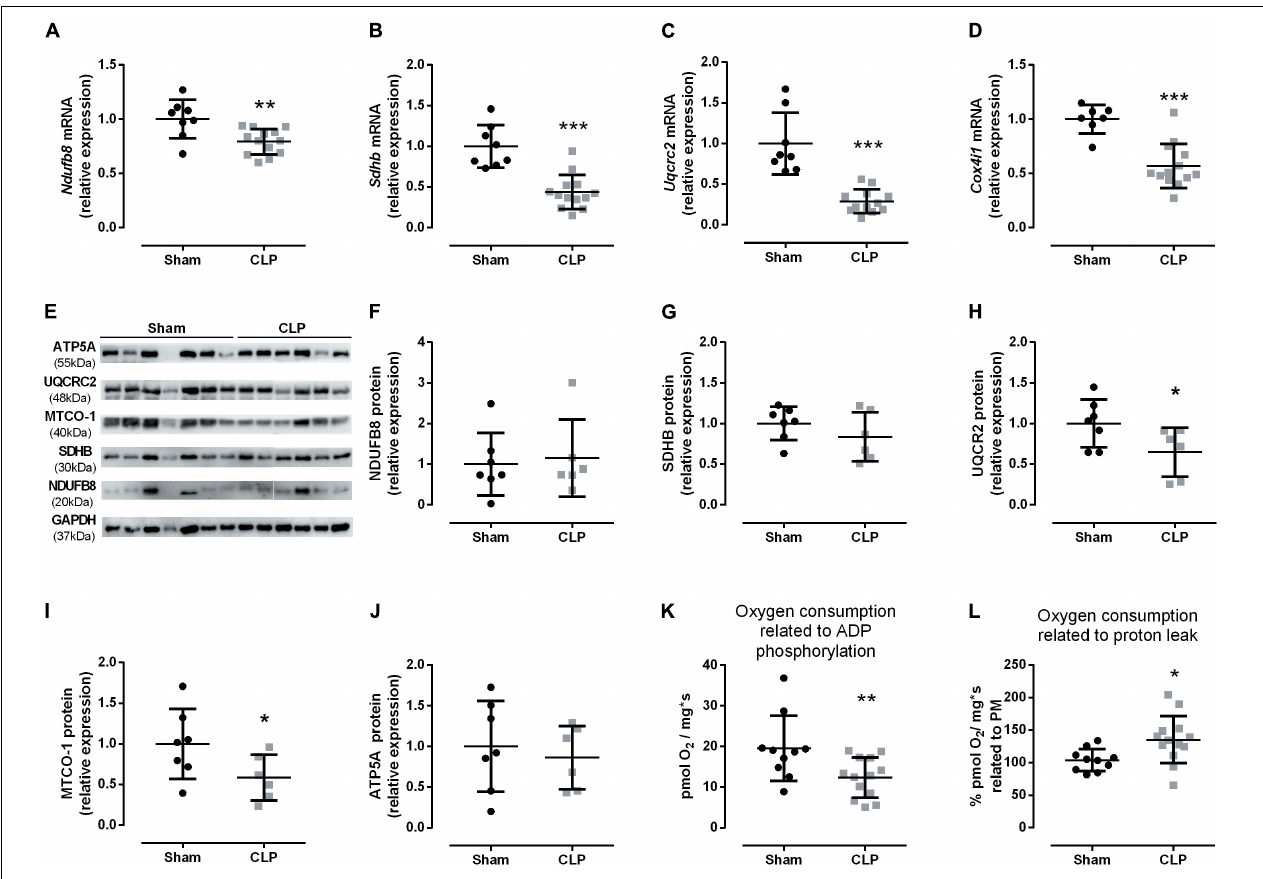
FIGURE 6 | Sepsis impairs diaphragm mitochondrial function. Expression of complex I ( Ndufb8 – A ); II ( Sdhb – B ); III ( Uqcrc2 – C ), and IV ( Cox4i1 – D ) in the diaphragm. Representative protein expression blot from complexes I–V (E) ; protein quantification of complex I (NDUFB8 – F ); complex II (SDHB – G ); complex III (UQCR2 – H ); complex IV (MTCO1 – I) ; ATP synthase (complex V; ATP5A – J ). Diaphragm HHR: oxygen consumption coupled to ADP phosphorylation (O 2 consumption after succinate administration values minus O 2 consumption after oligomycin administration values), the data values are an absolute measure of O 2 consumption (K) ; oxygen consumption related to proton leak (L) , values represent the percentage of O 2 consumption after oligomycin administration related to pyruvate and malate O 2 consumption values. Black dots represent sham animals caused by surgical stress, and gray squares represent CLP – cecal ligation puncture technique. Values are expressed as mean ± SD, * p < 0.05, ** p < 0.005, and *** p < 0.001 compared with sham